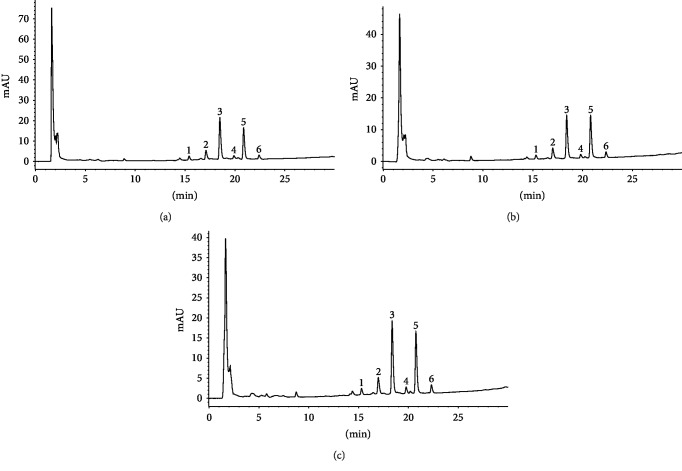
Chromatographic profiles of the hydroethanolic extract (a) 30% (HEJ30), (b) 50% (HEJ50), and (c) 70% (HEJ70) from Kalanchoe brasiliensis fresh leaves collected in January obtained by HPLC-DAD at 254 nm showing the presence of patuletin and eupafolin derivatives. Peak 1: flavonol indicating a methylated or glycosylated patuletin; peak 2: flavonol indicating a methylated or glycosylated patuletin; peak 3: flavone suggesting eupafolin or derivative or flavonol indicating a methylated or glycosylated patuletin; peak 4: flavone suggesting eupafolin or derivative; peak 5: flavonol indicating a methylated or glycosylated patuletin; and peak 6: flavone suggesting eupafolin or derivative.